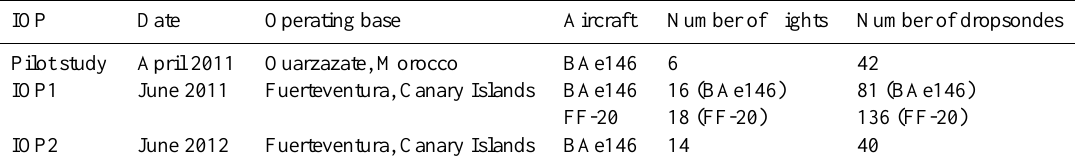
Table 2. Overview of